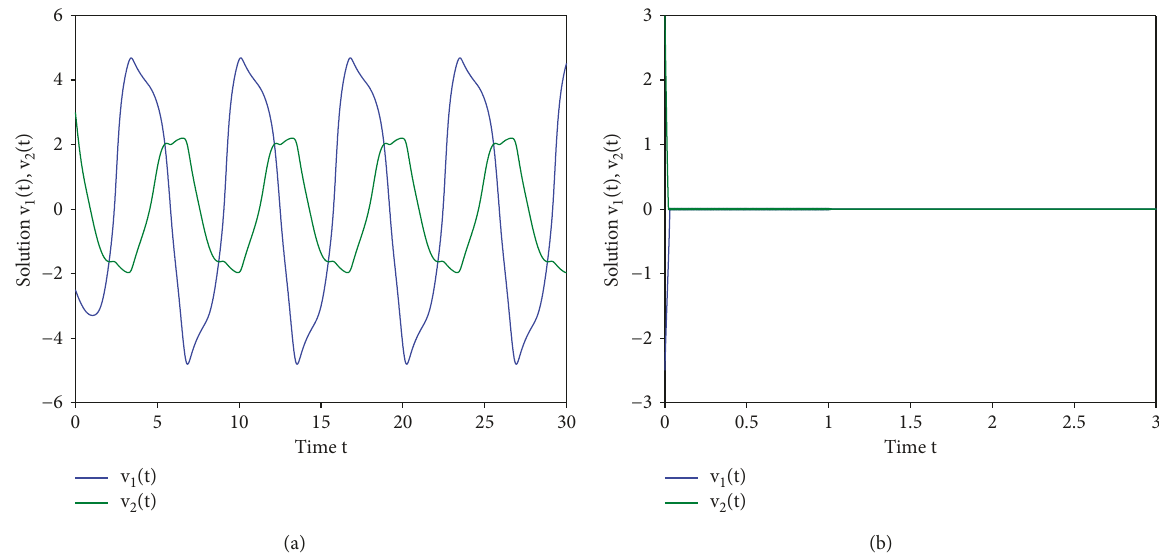
t and v t in (69) without any controllers. (b) The trajectories of state variables v 1 2